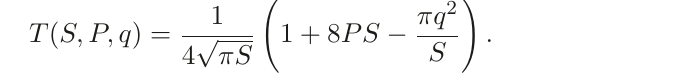
Figure 5. The YM charge set to q = 1 . 9. The pressure varies from P c from bottom to